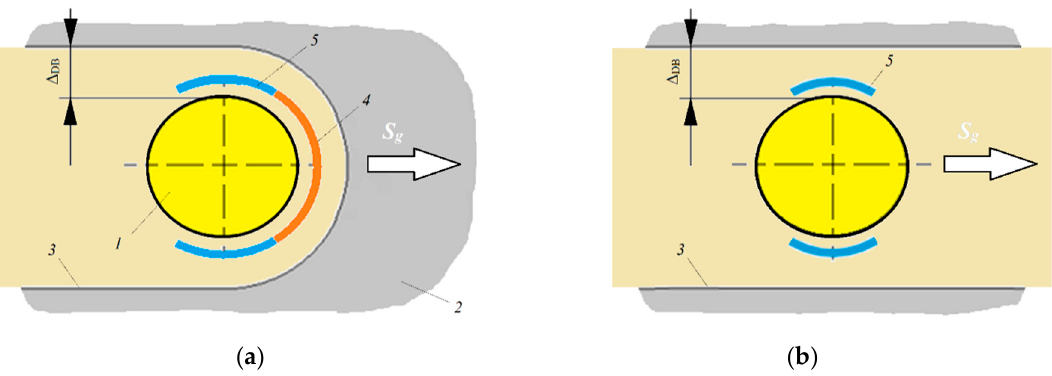
Figure 14. Non-profiled tool electrode wear: ( a ) at roughing; ( b ) at finishing, where ( 1 ) is a tool electrode, ( 2 ) is a workpiece, ( 3 ) is machined surface, ( 4 ) is front wear, ( 5 ) is lateral wear, and S g is a guidance feed of wire.